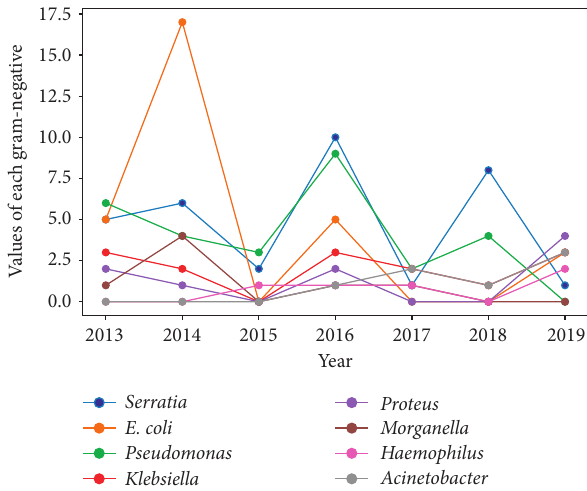
Figure 11: Percentage of gram negative